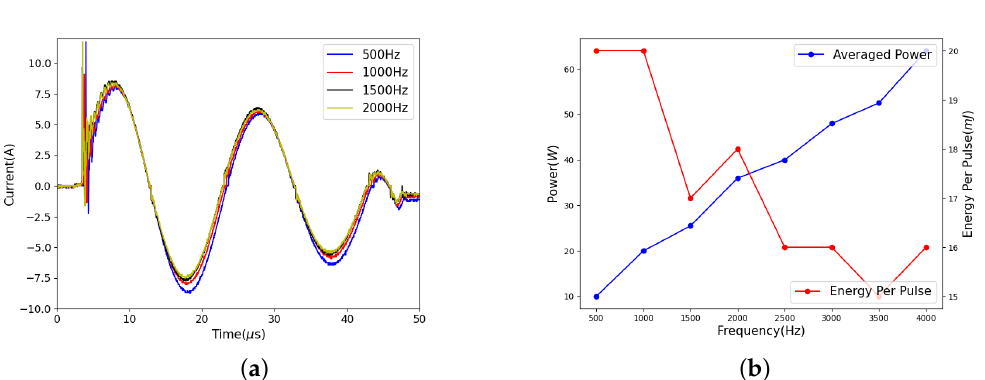
Figure 3. ( a ) Current waveform; ( b ) average power and energy per pulse at different discharge frequencies.